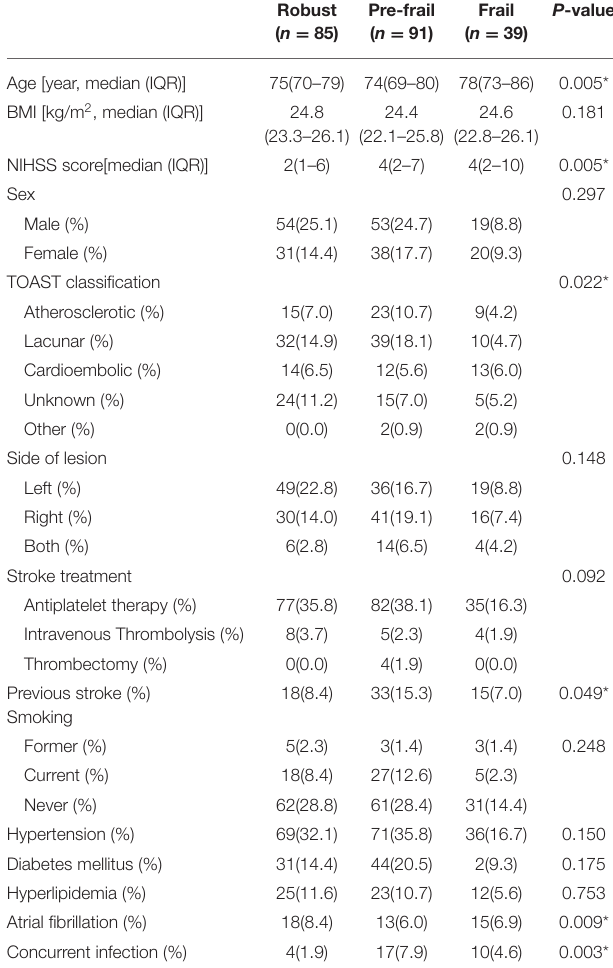
* Indicates a signicant difference (p < 0.05) between non-frail and frail. was assessed by mRS (scored from 0 to 5). NIHSS score and